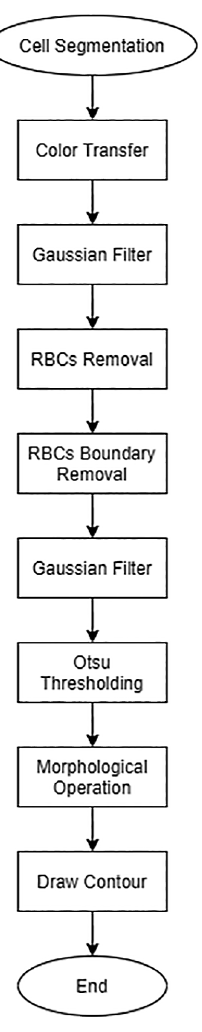
Figure 1. Flowchart of proposed cell